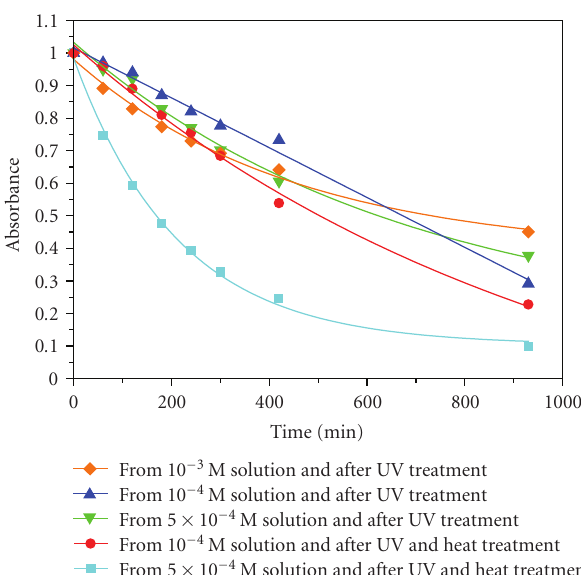
From 10 − 3 M solution and after UV treatment From 10 − 4 M solution and after UV treatment From 5 × 10 − 4 M solution and after UV treatment From 10 − 4 M solution and after UV and heat treatment From 5 × 10 − 4 M solution and after UV and heat treatment Figure 4: Photodegradation curves of AZS with black light illumination in presence of Pt modified TiO 2 films at various platinum concentrations and treatments of the films.